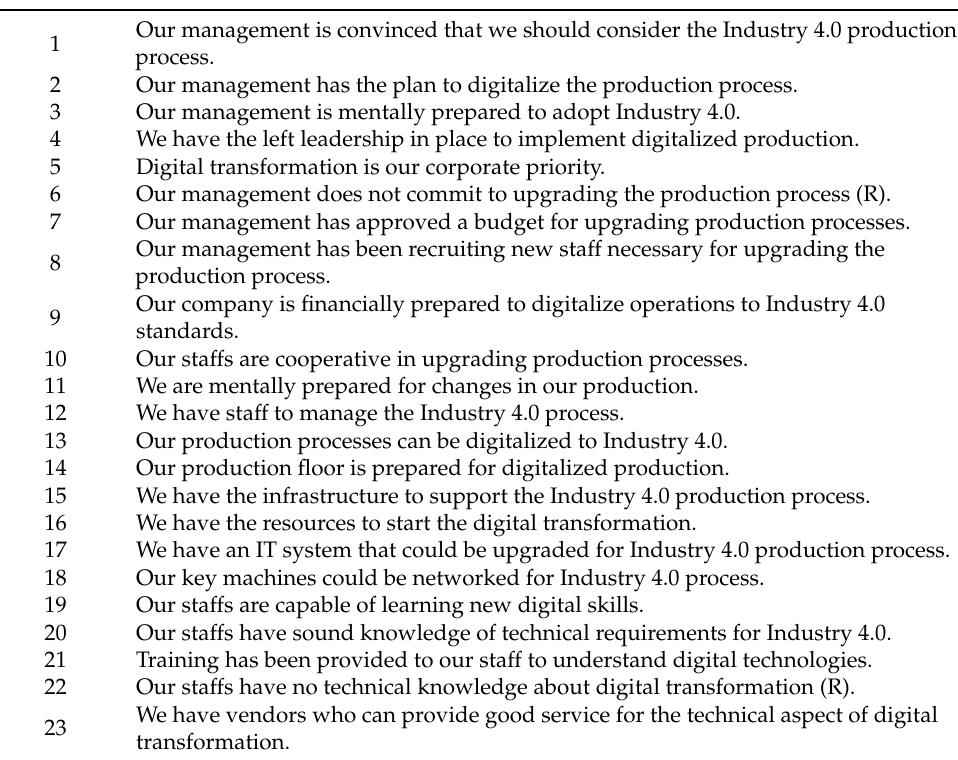
Table 2. Measurement items for managerial readiness, operational readiness, and technological readiness.